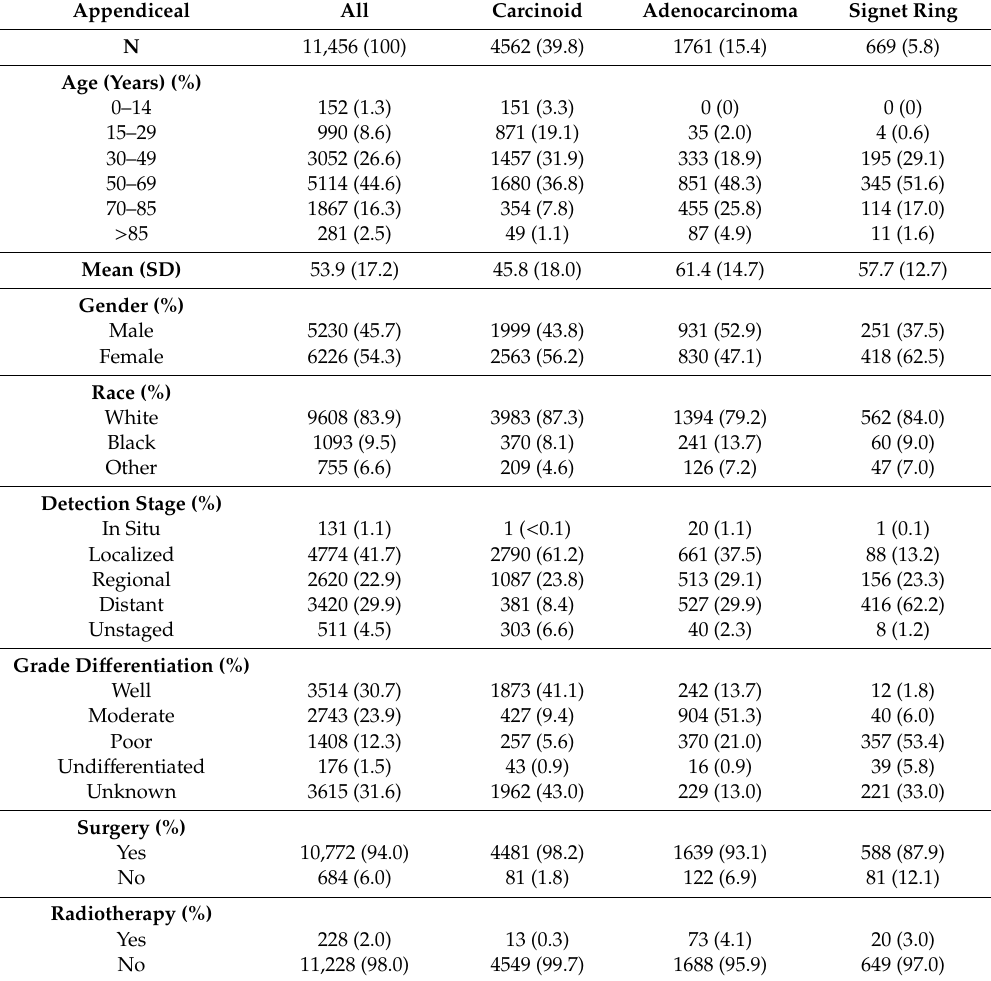
Table 13. Baseline demographics and clinical characteristics by histology for appendiceal